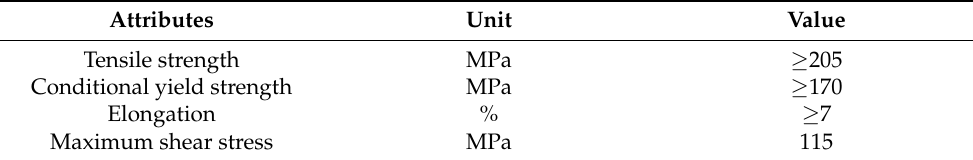
Table 4. 6063 aluminum alloy performance parameter table at 25 ◦